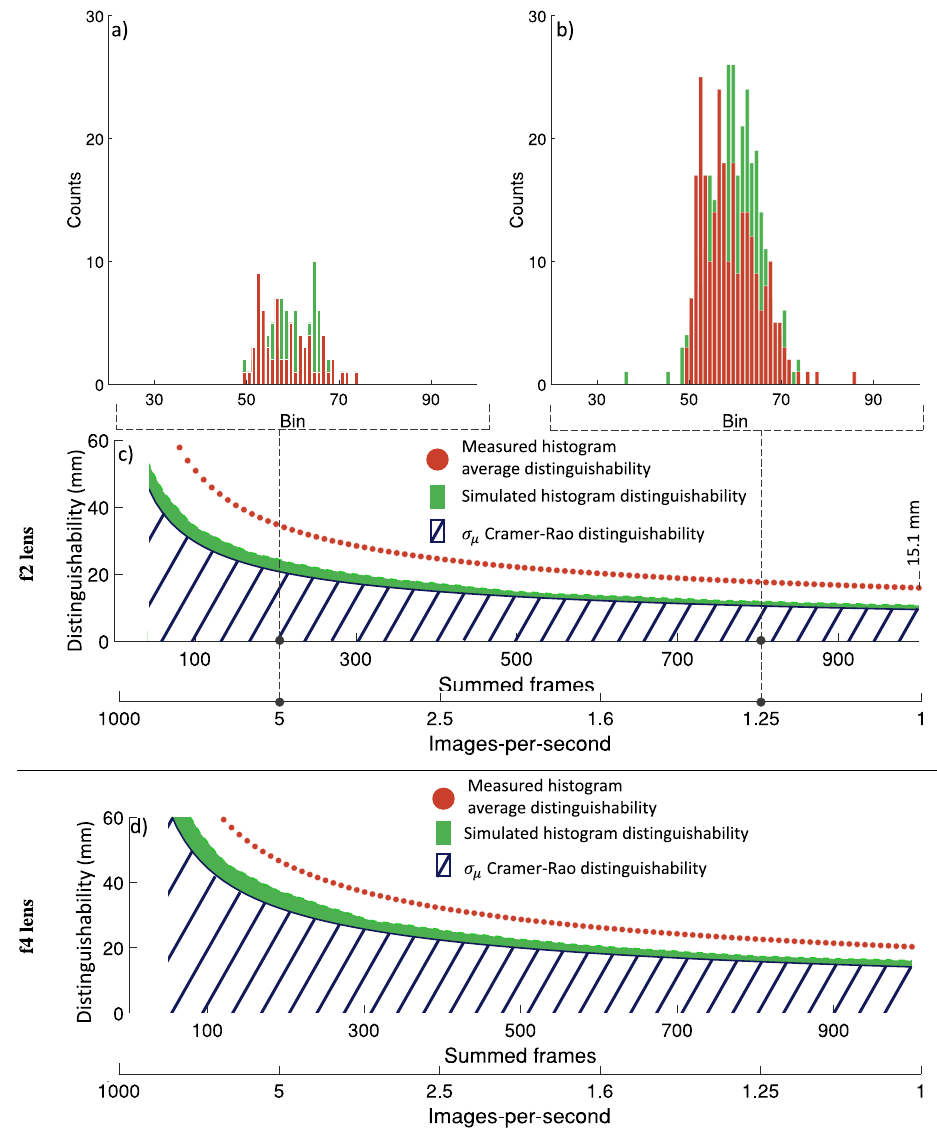
Figure 6. The simulated minimum distinguishability based on Eqs. (6) and (7) overlayed with the experimentally obtained average distinguishability of the resolution test target (Fig. 5 bottom row). c) the lower bounds on distinguishability as determined by Eqs. (6) and (7) shown in blue and green respectively for the case of an f2 lens. The average distinguishability based on experimental histogram variance is shown as orange dots. The upper sub-panels, a) and b), show exemplar simulated histograms (green) with experimentally obtained histograms (for a single pixel) overlayed in orange at the positions indicated by the risers. d) the lower bounds on distinguishability as determined by Eqs. (6) and (7) shown in blue and green respectively with the experimentally obtained average distinguishability overlayed as orange dots for the case of an f4 lens. At less than 50 summed frames the simulated histograms contain no counts and the minimum distinguishability becomes